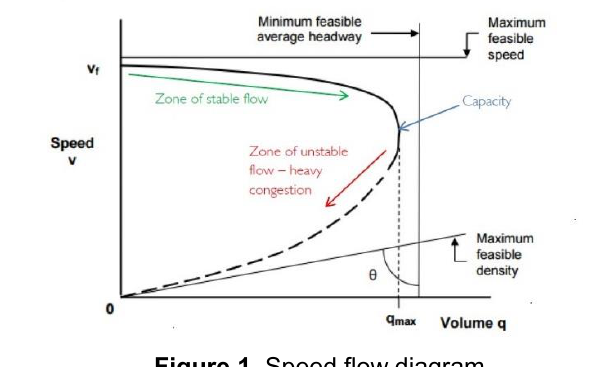
Figure 1. Speed flow